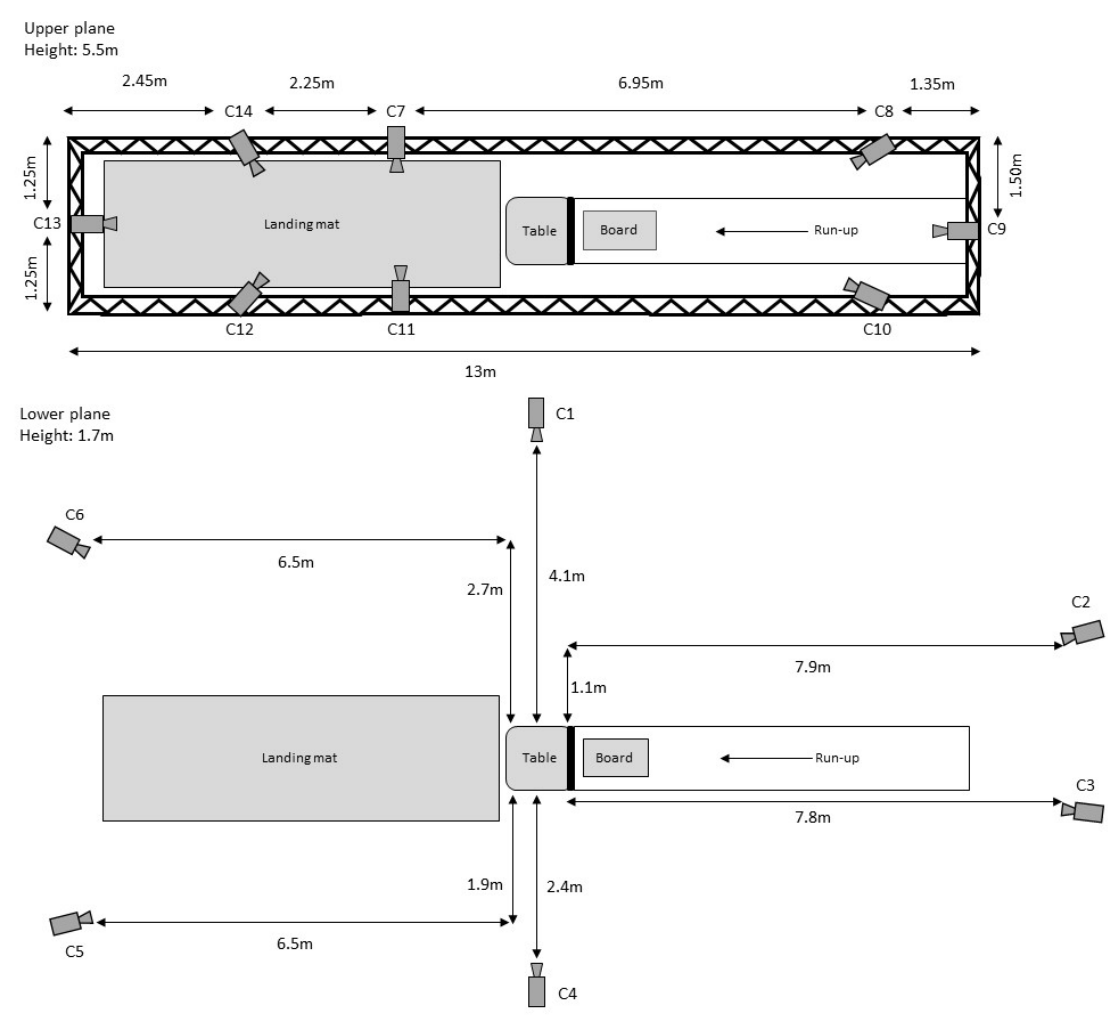
Figure 2. Arrangement of the 14 Vicon Vantage Cameras (C1 to C14) for 3-dimensional motion capture of vaults.